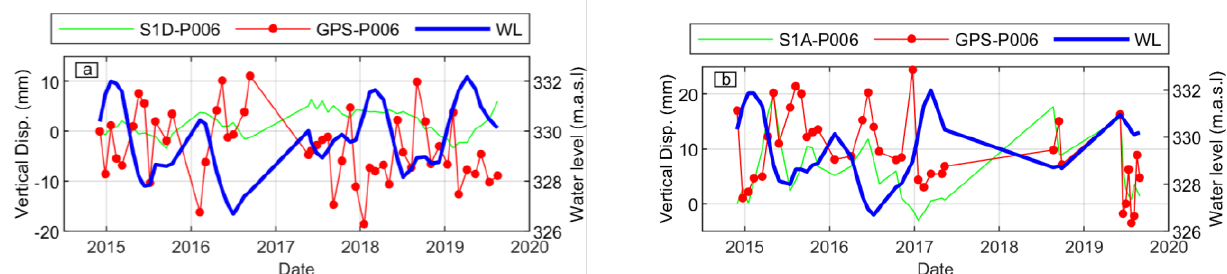
Figure 6. Validation with GPS station during the S1 period. Cross−comparison between vertical ground displacements at station P006 from both GPS measurements and SBAS during the S1 period for both ( a ) descending and ( b ) ascending modes. Table 3. Accuracy assessment of the time-series of the SBAS − S1 displacements. RMSE and R corresponding to results of Figure 6. S1 Ascending-P006 S1